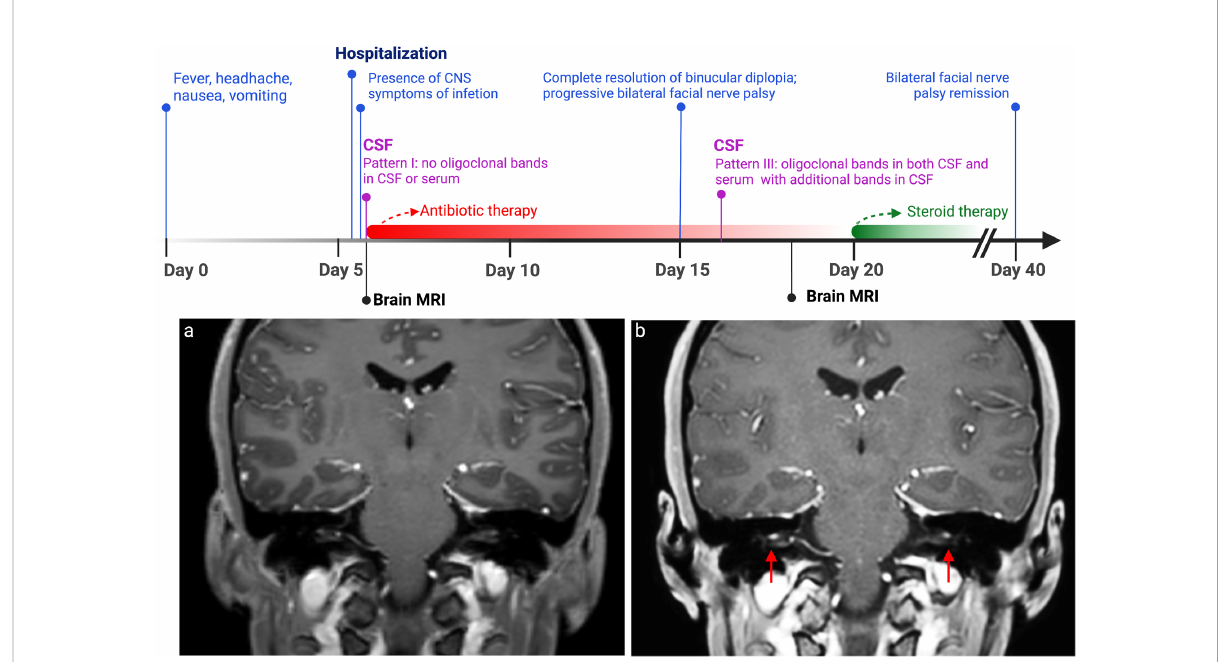
FIGURE 1 Disease timeline. In this timeline are displayed clinical (shown in blue) and CSF (in purple) changes in relation to antibiotic course (in red) and steroid therapy (in green). On the bottom, MRI T1-weighted imaging with gadolinium contrast performed after 18 days from clinical onset (A) demonstrated bilateral pathologically relevant gadolinium enhancement in VII and VIII cranial nerves ’ intrameatal tract bilaterally (red arrows), which was not present in the fi rst MRI (B) . CSF, cerebrospinal fl